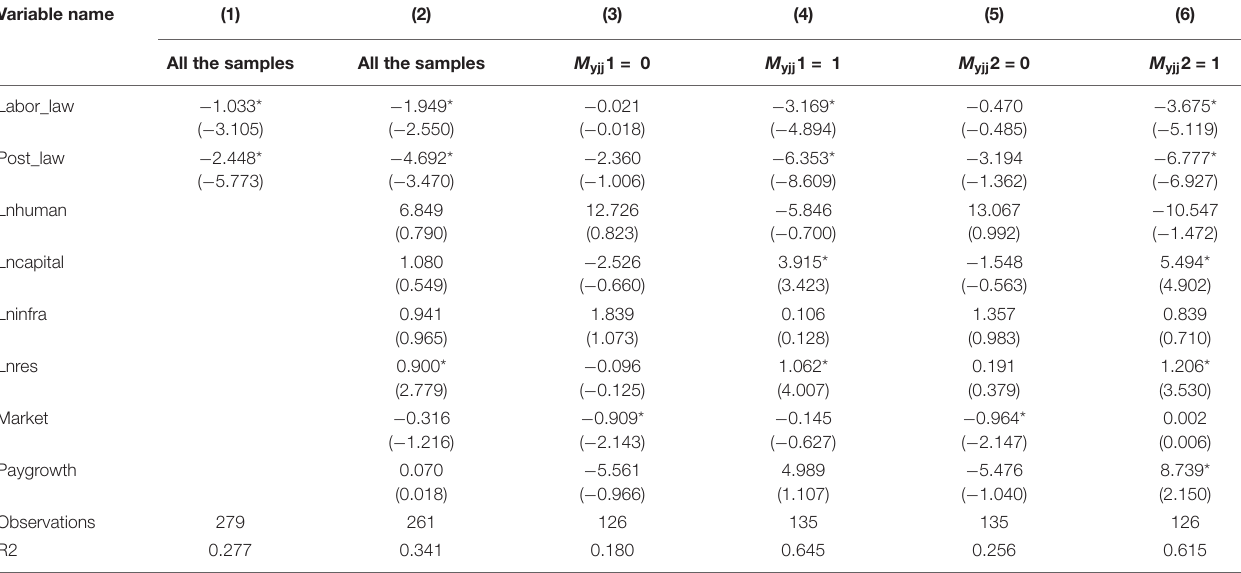
TABLE 5 | Labor Protection Law, proportion of private economy and regional economic